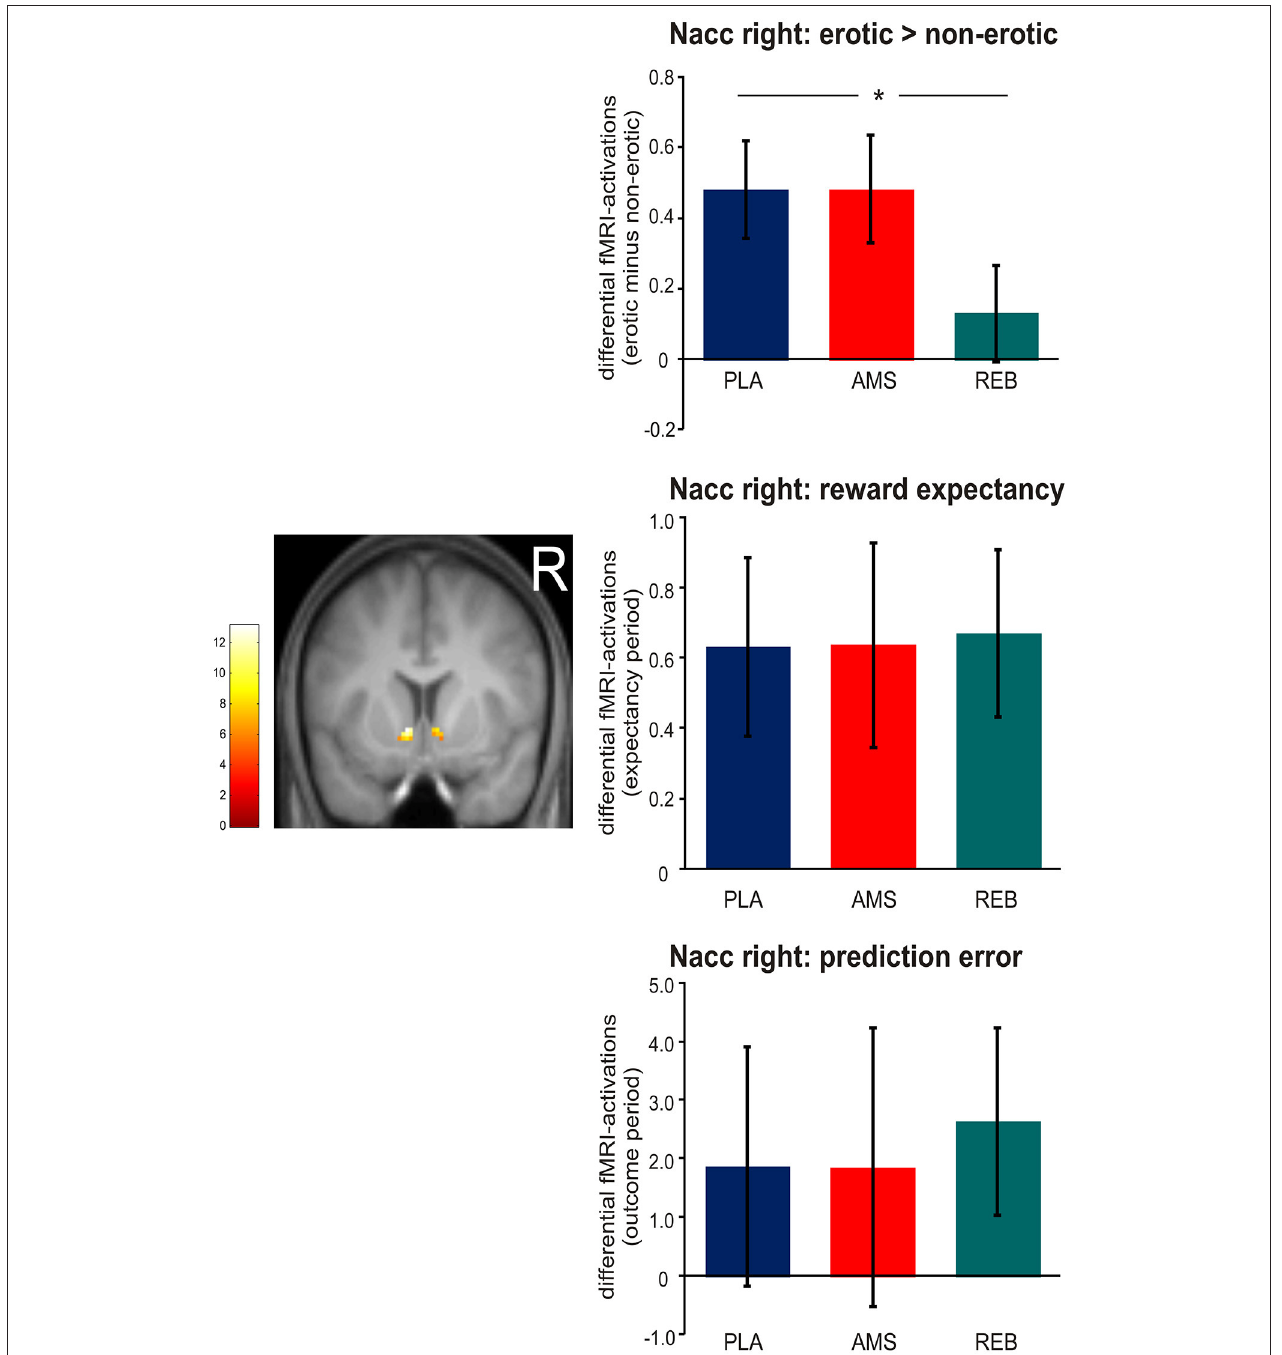
FIGURE 3 | Neural activations within the right nucleus accumbens (Nacc) observed during static visual erotic picture stimulation and during the monetary reward paradigm. For demonstrational purposes, parameter estimates were extracted solely from the right Nacc. The brain image depicts differential (erotic minus non-erotic) neural activations within the Nacc mask provided by the Harvard-Oxford cortical and subcortical structural atlas during the static erotic picture paradigm. Bar graphs depict differential neural activations with standard error of the mean (sem). Corresponding parameter estimates were extracted only from the right Nacc cluster for demonstrational purposes. In detail, the upper panel shows differential (erotic minus non-erotic) neural activations under placebo (PLA), amisulpride (AMS), and reboxetine (REB). Here, post-hoc t- tests revealed significant attenuated fMRI-activations under REB vs. PLA (*statistical significance). The middle panel depicts differential fMRI-activations (individually weighted by linear contrasts, see Materials and Methods section) during the expectancy period in the monetary reward paradigm. Bar graphs in the lower panel show differential fMRI-activations modeling prediction error (also weighted with linear contrast).